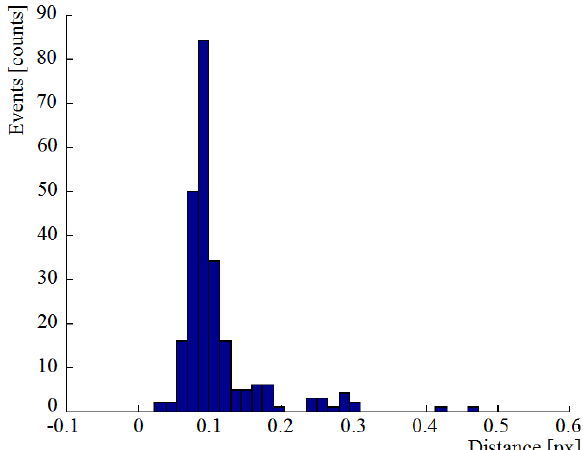
Figure 4. Histogram Euclidean distances between centroids computed by Gaussian fitting and estimation the mean 2D.